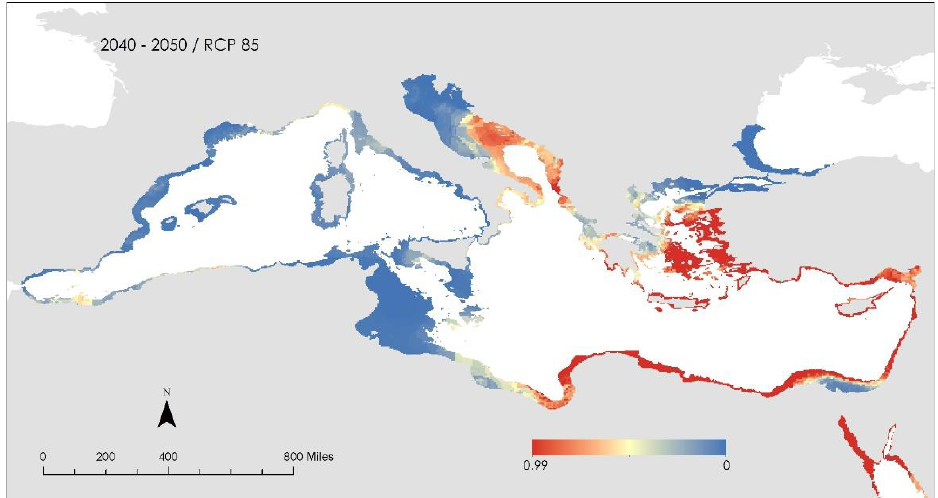
Figure 5. Lionfish potential distribution under RCP85 for the period 2040 – 2050.